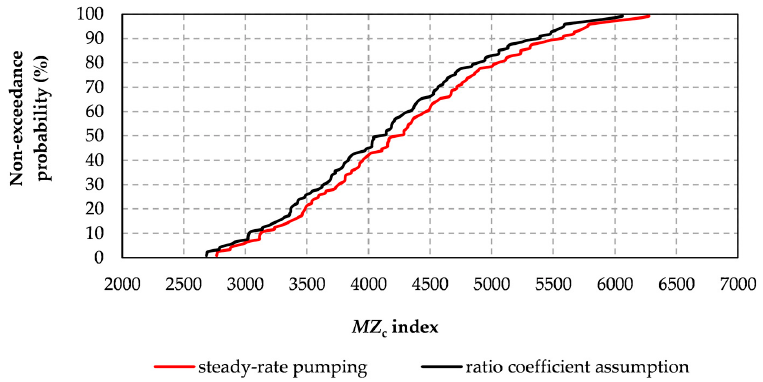
Figure 15. Comparison between steady-rate pumping and pumping according to the ratio coefficient assumption of the same daily sewage amount. The figure depicts the non-exceedance probability corresponding to each MZ c index value concerning the pipe path from the optimal node of area ID 3 to the network’s exit node.